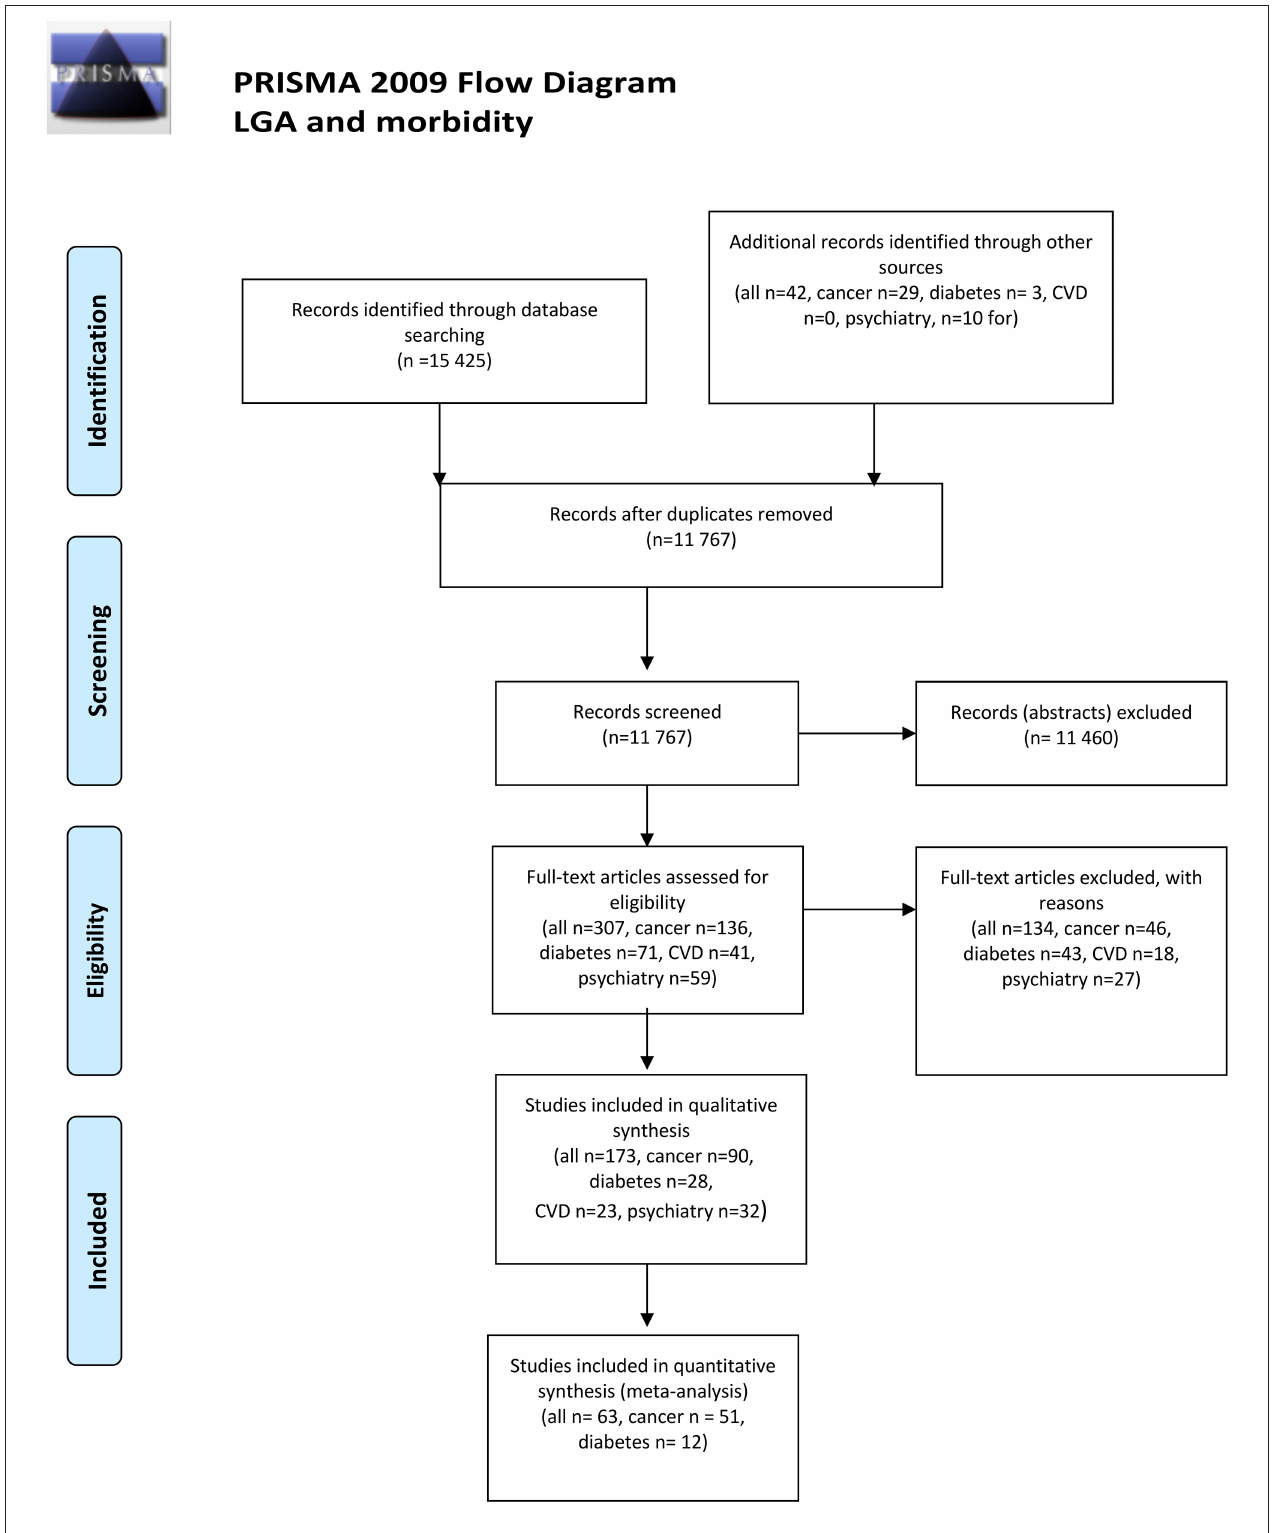
FIGURE 1 | PRISMA flow chart. From Moher et al. (22). For more information, visit www.prisma-statement.org.